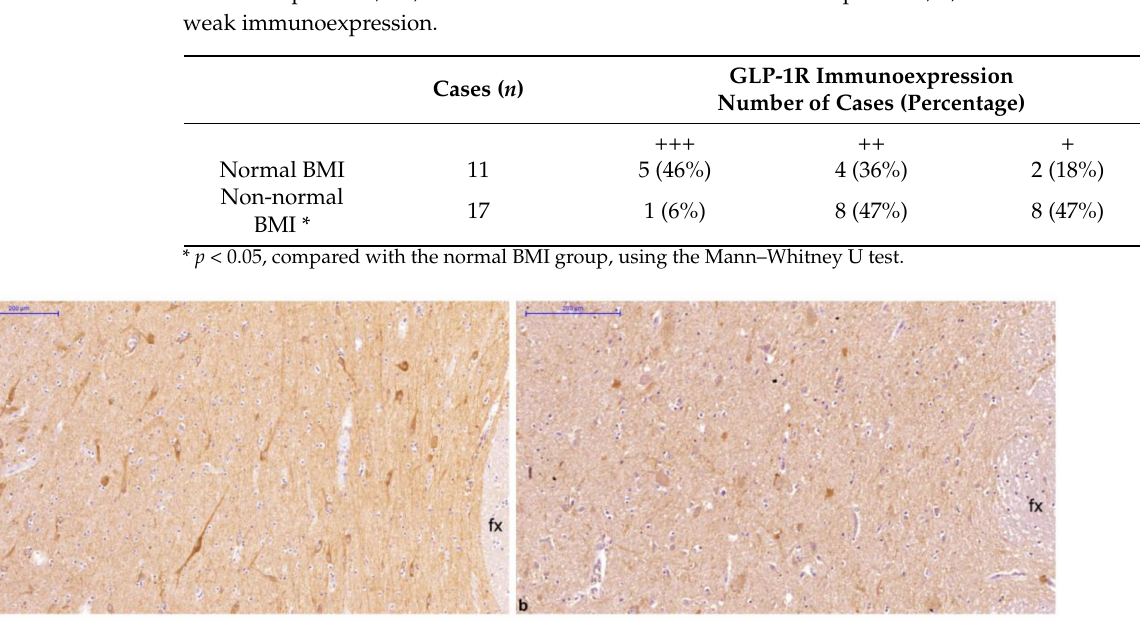
Figure 3. Comparison of GLP-1R immunoexpression in lateral hypothalamic area from a normal weight and a non-normal weight individual, both with similar clinicopathological characteristics. Images taken in similar rostrocaudal levels (medial zone of the tuberal region) are derived from a male with BMI 23.0 kg/m 2 , displaying high GLP-1R immunoreactivity, ( a ) and a male with BMI